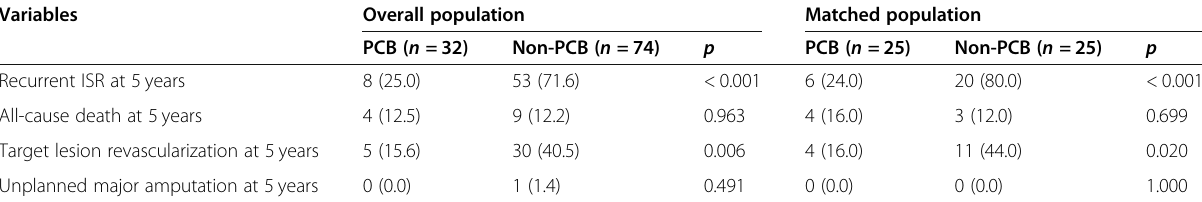
Table 4 Clinical Events after Treatment for In-stent Restenosis at 5 years